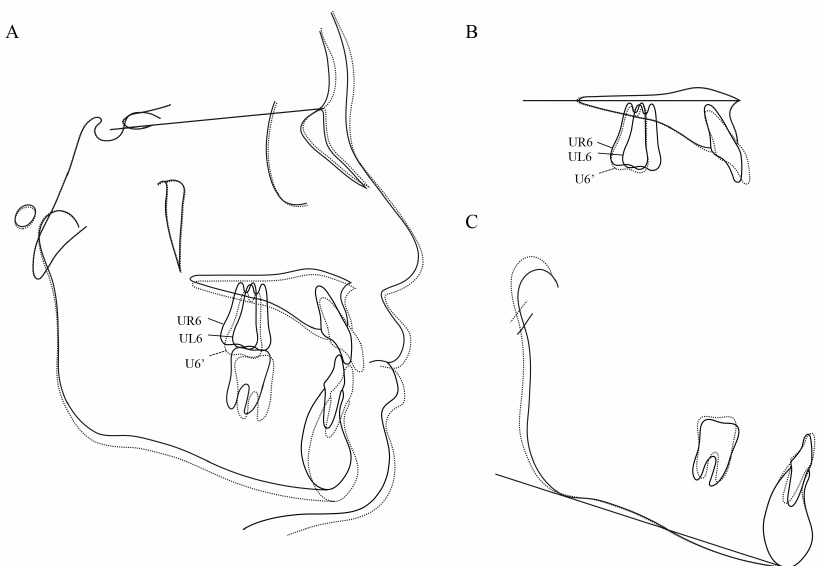
Figure 11. Superimposition at the start of active treatment and at termination of active treatment. ( A ) On the SN plane at S. ( B ) On the palatal plane at ANS. ( C ) On the mandibular plane at Me. At the start of active treatment (14 years 4 months) (solid line); at termination of active treatment (17 years 9 months) (dashed line). Maxillary right first molar at the start of active treatment (UR6); maxillary left first molar at the start of active treatment (UL6); maxillary first molar at termination of active treatment (midpoint of the left and right sides) (U6 (cid:48) ).